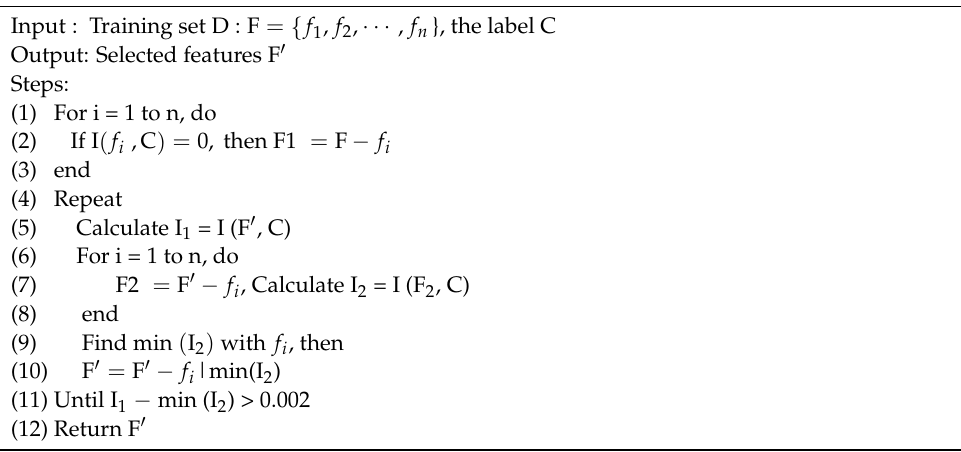
Algorithm 1. GCMI-based feature selection